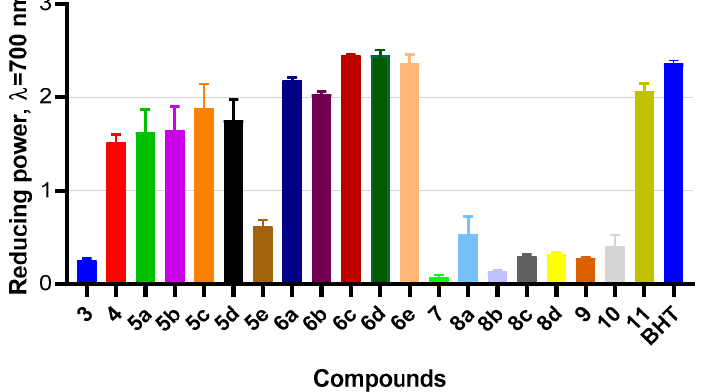
Figure 3. Evaluation of ferric ion (Fe 3+ ) reducing antioxidant power of 3 – 11 compounds and synthetic antioxidant BHT. Data are shown as mean ± SD from three experimental replicates.